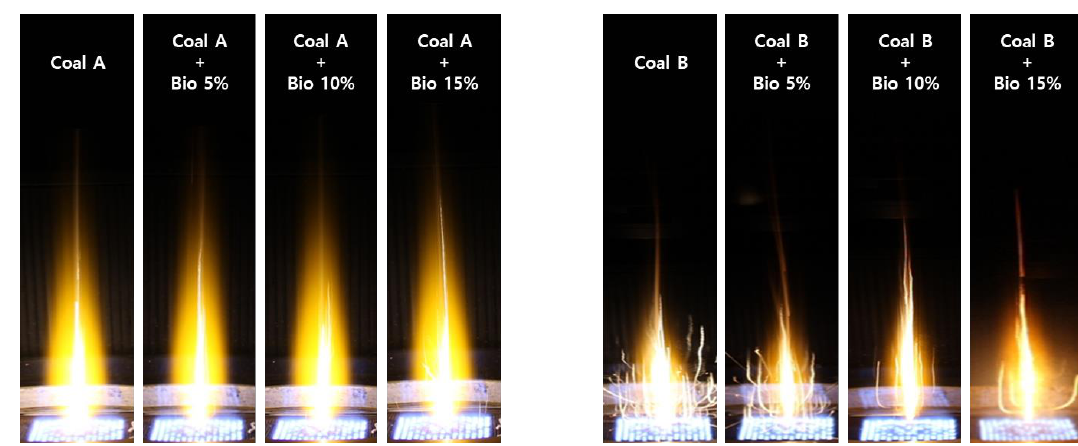
Figure 5. Flame structure of the burning coal particles (O 2 = 26%).